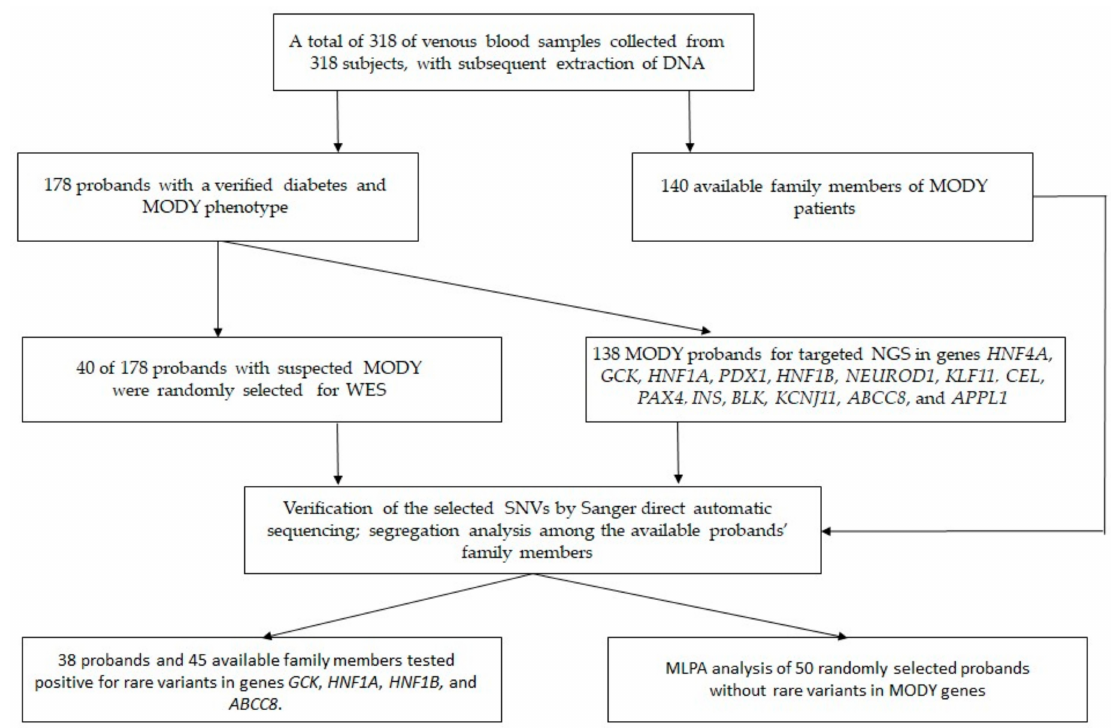
Figure 1. The study design. DNA: deoxyribonucleic acid, MLPA: multiplex ligation-dependent probe amplification, MODY: maturity onset diabetes of the young, SNV: single-nucleotide variant, WES: whole-exome